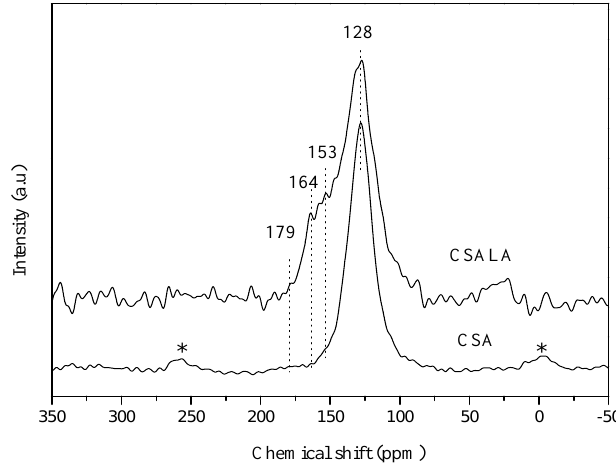
Figure 3. 13 C CP/magic angle spinning (MAS) NMR spectra of CSA and CSALA. * denotes spinning sidebands.